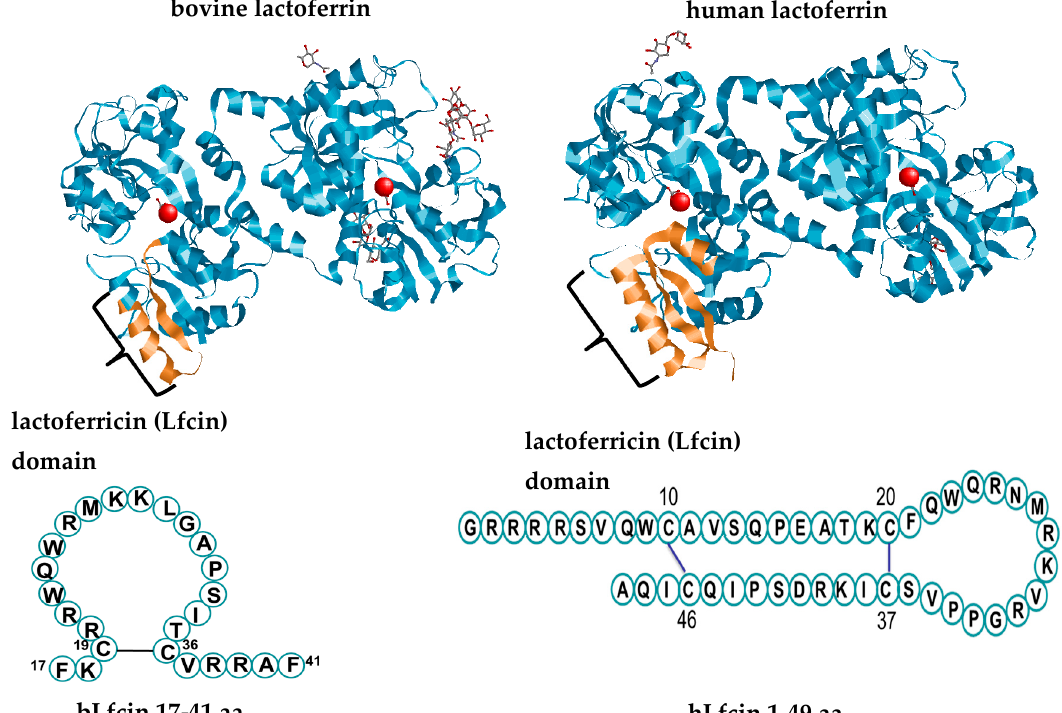
Figure 1. The canonical structure of lactoferrin (Lf) (bovine lactoferrin Protein Data Bank (PDB)